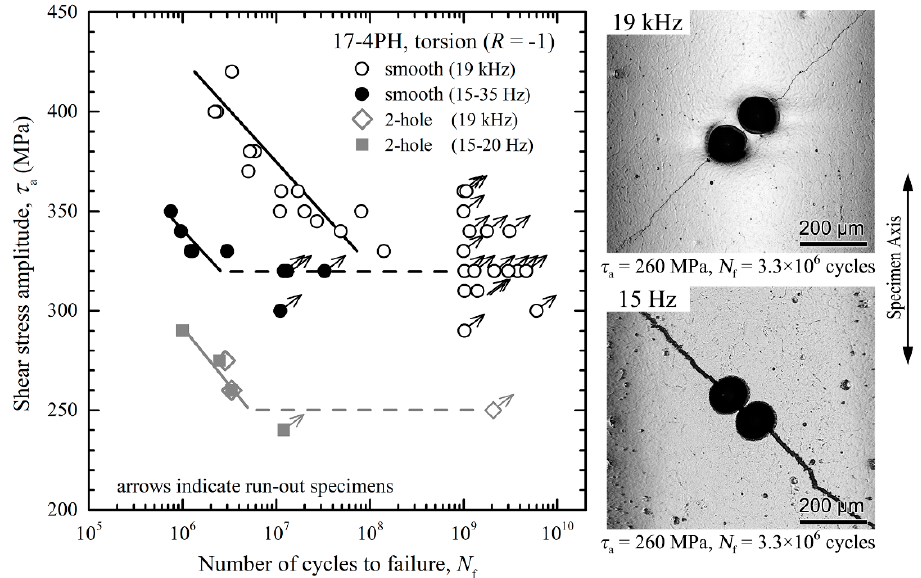
Figure 10. Servo-hydraulic and ultrasonic torsional fatigue tests with martensitic stainless steel 17-4PH (smooth and 2-hole defect containing specimens) [59].